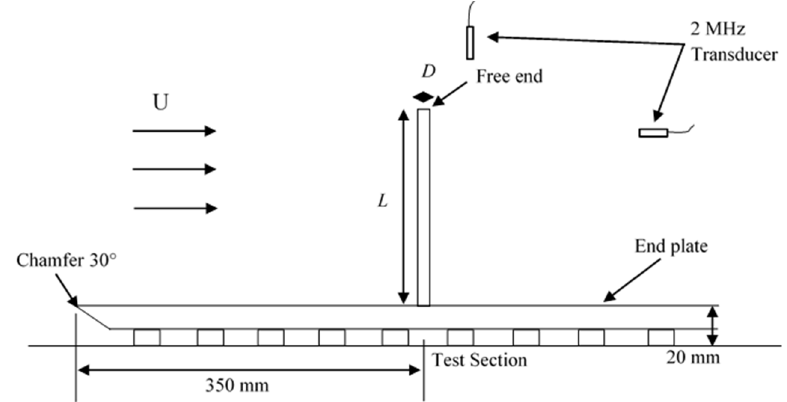
Figure 8. Schematic diagram of experimental set-up in the water tunnel.